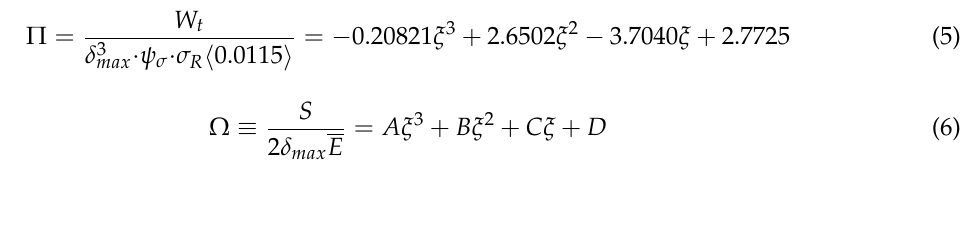
Figure 6. Mechanical properties of the Sn–3.0Ag–0.5Cu (SAC305) solder: ( a ) Young’s modulus; ( b )